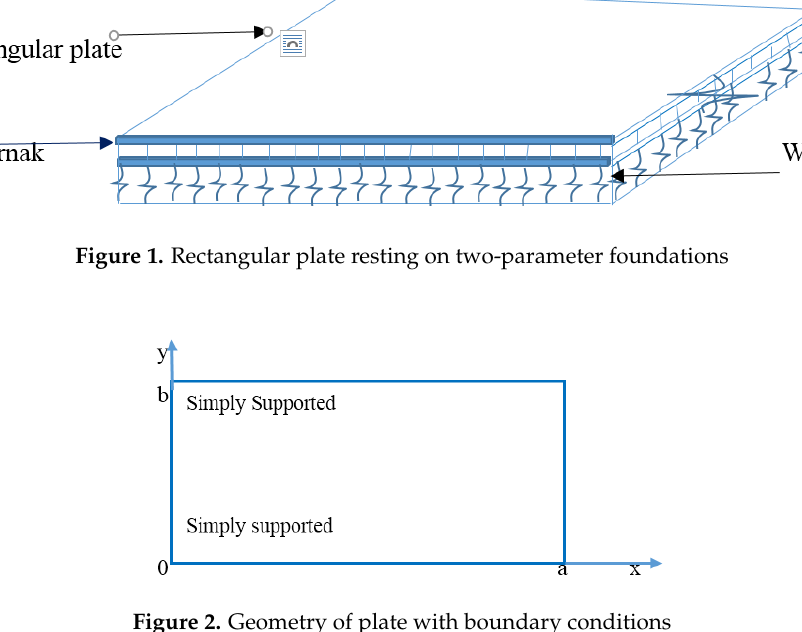
Figure 2. Geometry of plate with boundary